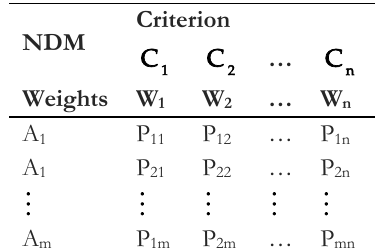
Table 4. Normalized Decision Matrix (NDM).